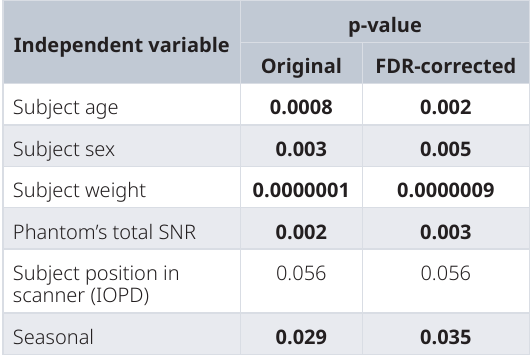
Table 3. Independent variables’ original and FDR- corrected p-values from the model for gray